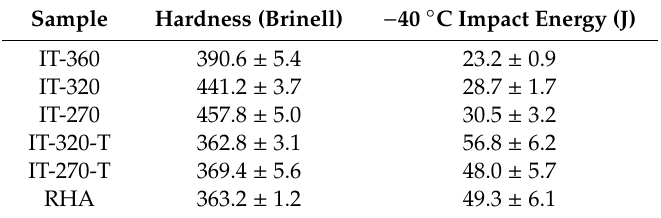
Table 3. Hardness and − 40 °C impact energies of the ballistic test samples.